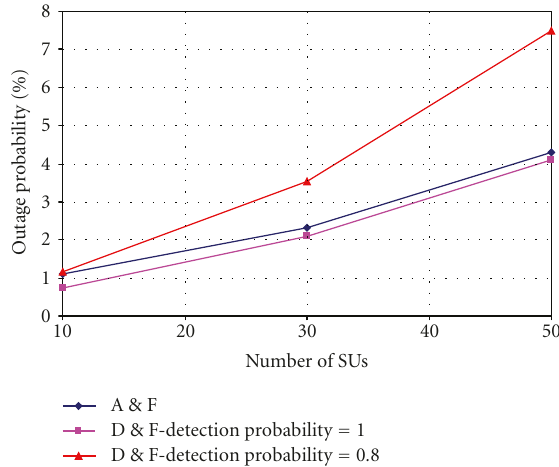
Figure 11: Comparison of D&F and A&F outage performance